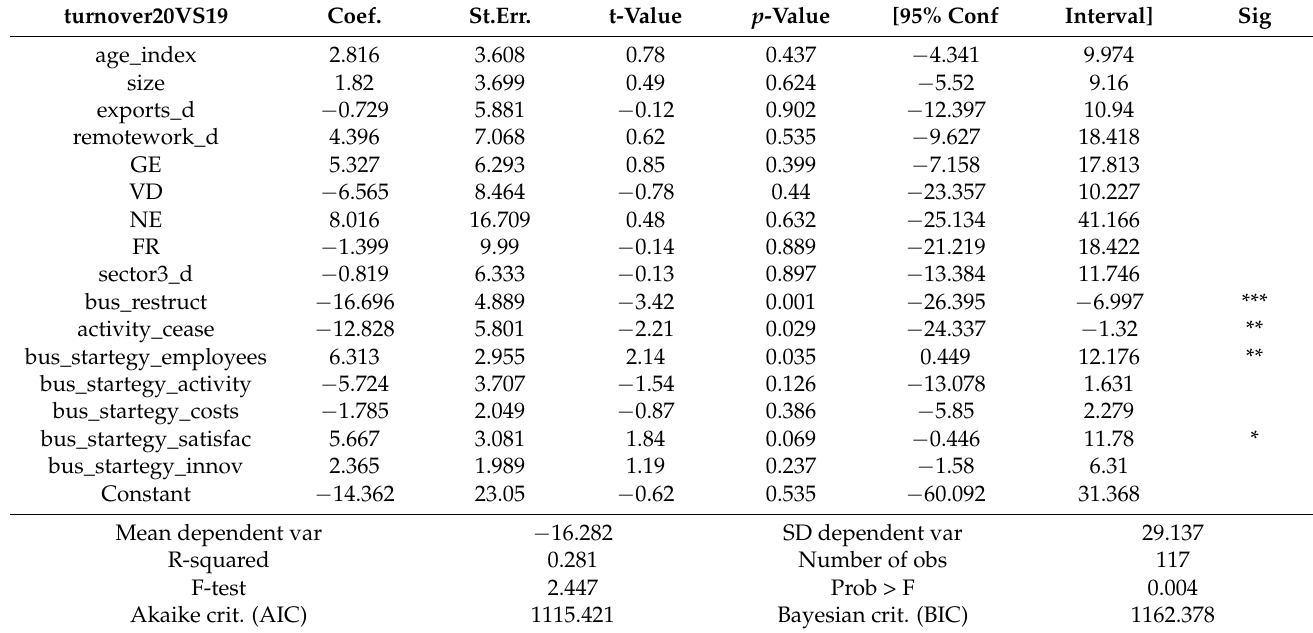
Table 12. Regression results with business management